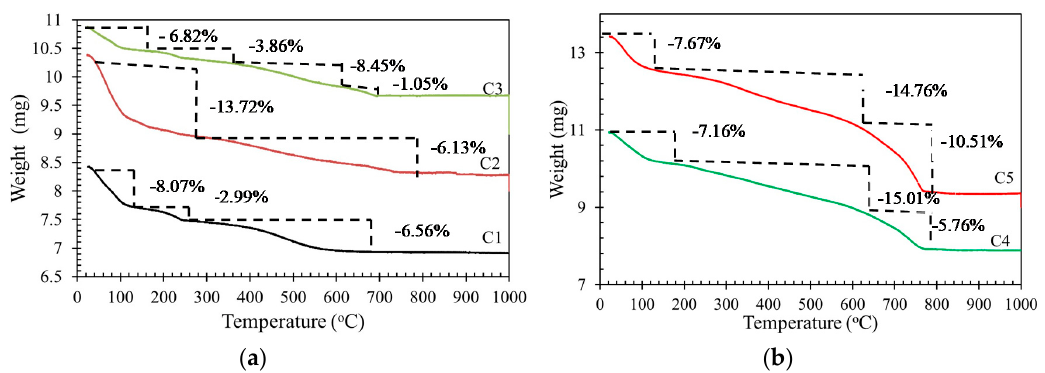
Figure 2. ( a ) Thermogravimetric analysis (TGA) curves of C1, C2 and C3 clays. ( b ). TGA curves of C4 and C5 clays.